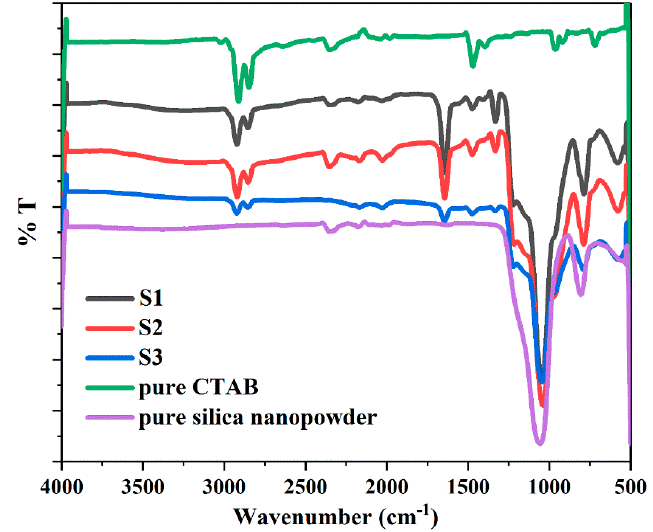
Figure 8. FTIR spectra of pure CTAB and synthesized samples S1, S2 and S3.